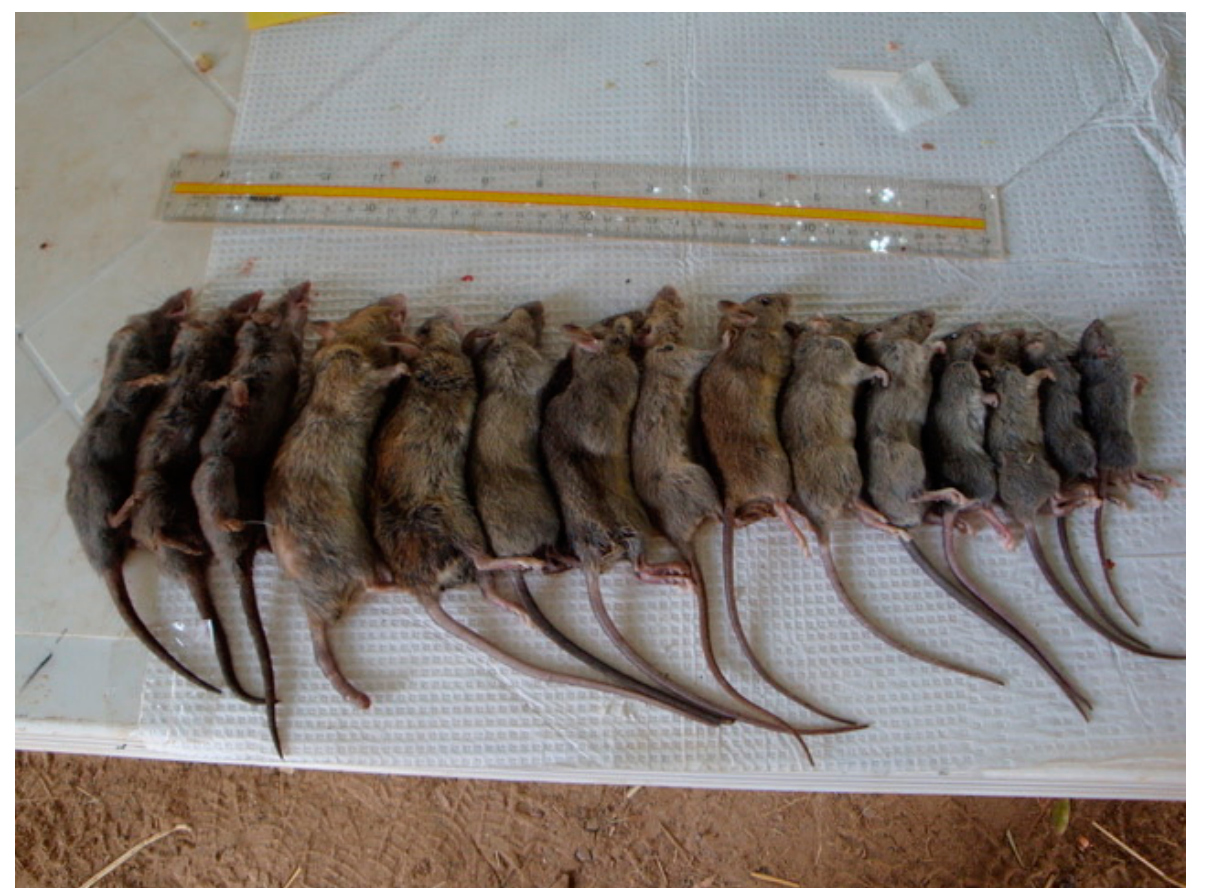
Figure 1. Geographic distribution of Mastomys natalensis and Mastomys erythroleucus in sub ‐ Saharan Africa. Shown are the distributions of M. natalensis (shaded green) and M. erythroleucus (red ‐ hatched) across sub ‐ Saharan Africa. Inset denotes the village of Doneguebougou (triangle), where the founder rodents for the colony were live ‐ trapped, in relation to the capital city of Bamako, Mali.